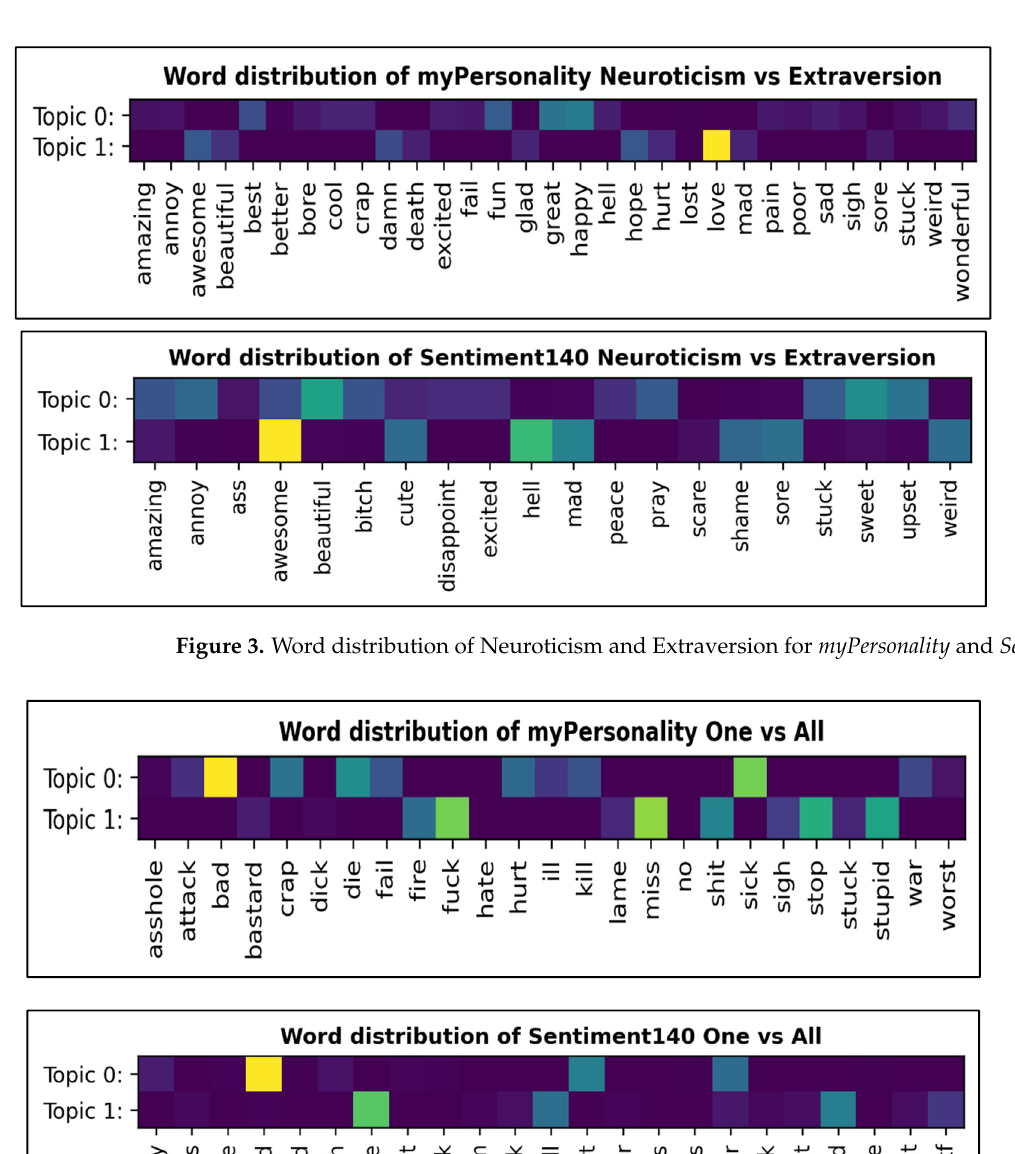
Table 9. Probability of top three seed words.